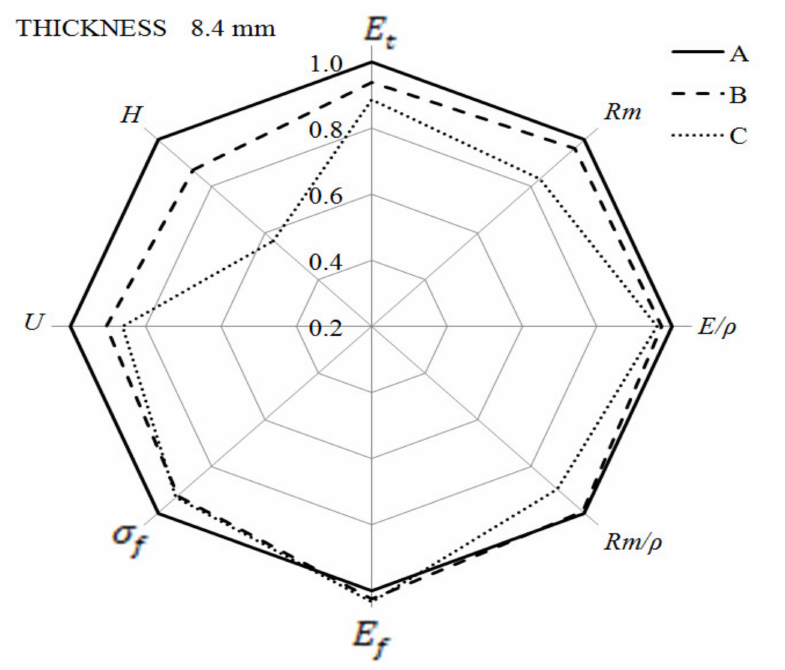
Figure 30. Changes in mechanical properties of 8.4 mm-thick foamed samples as compared to solid PA66 GF30